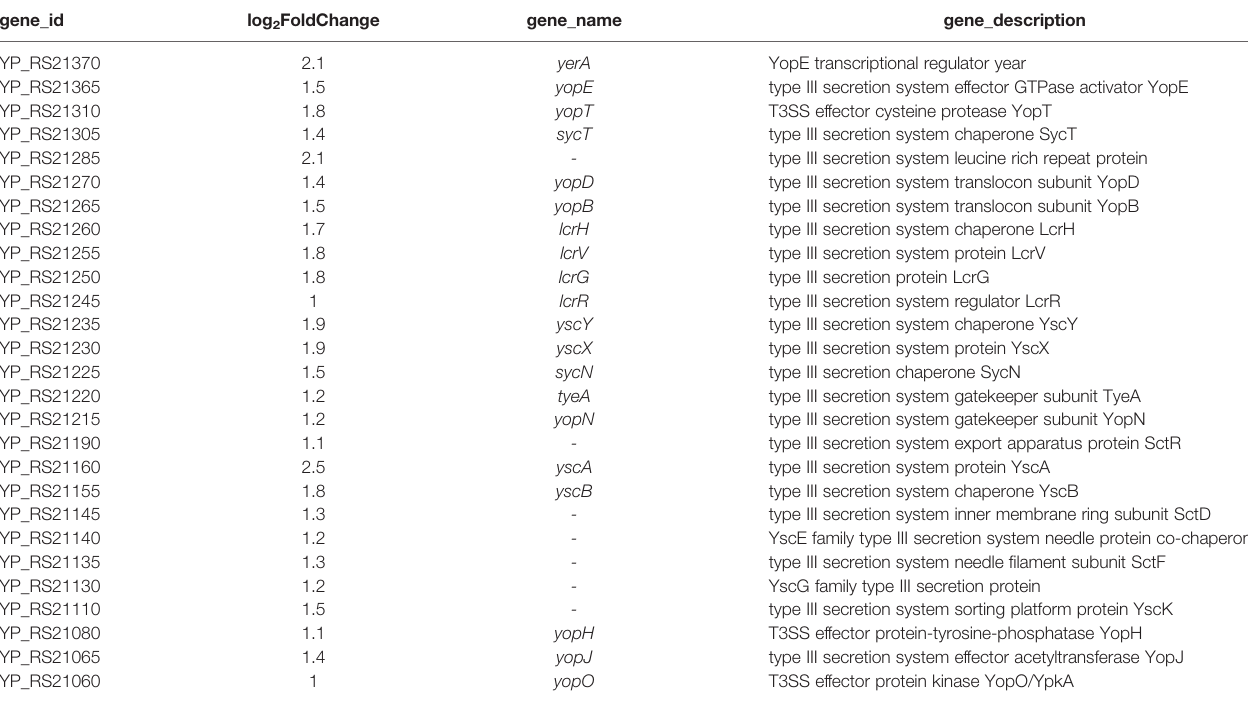
TABLE 3 | The genes of type III secretion system were up-regulated in D fyuA GCAdel in comparison with 201-WT at 37°C. gene_id log 2